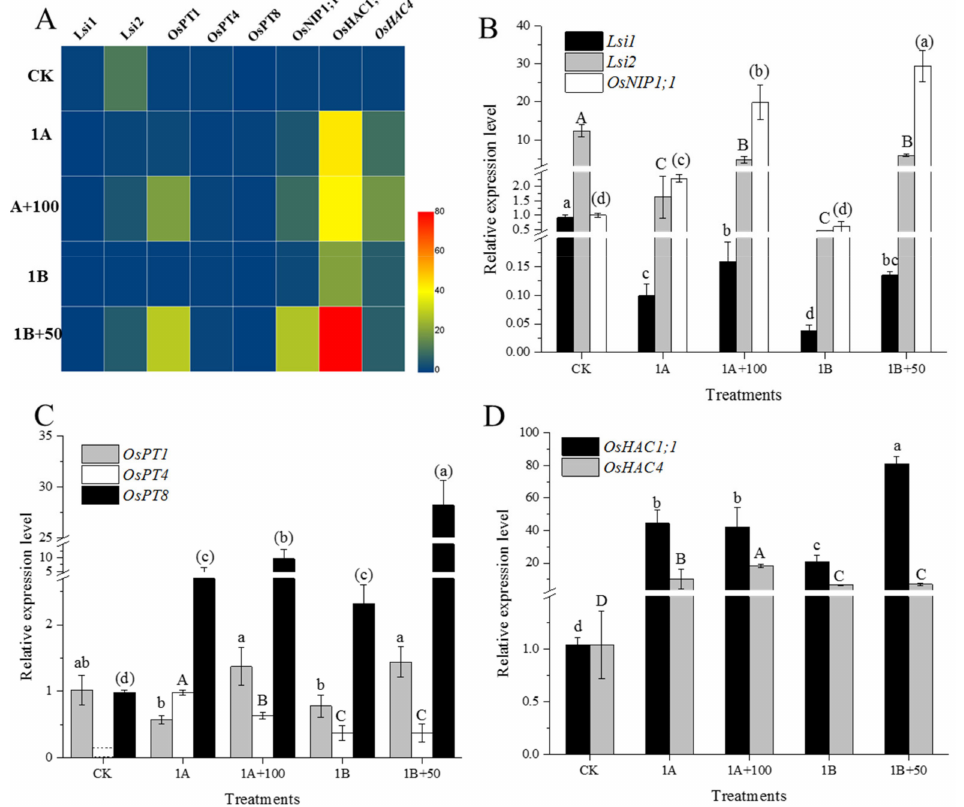
Figure 4. Heatmap ( A ) and relative expression level of As related genes ( B – D ) in rice